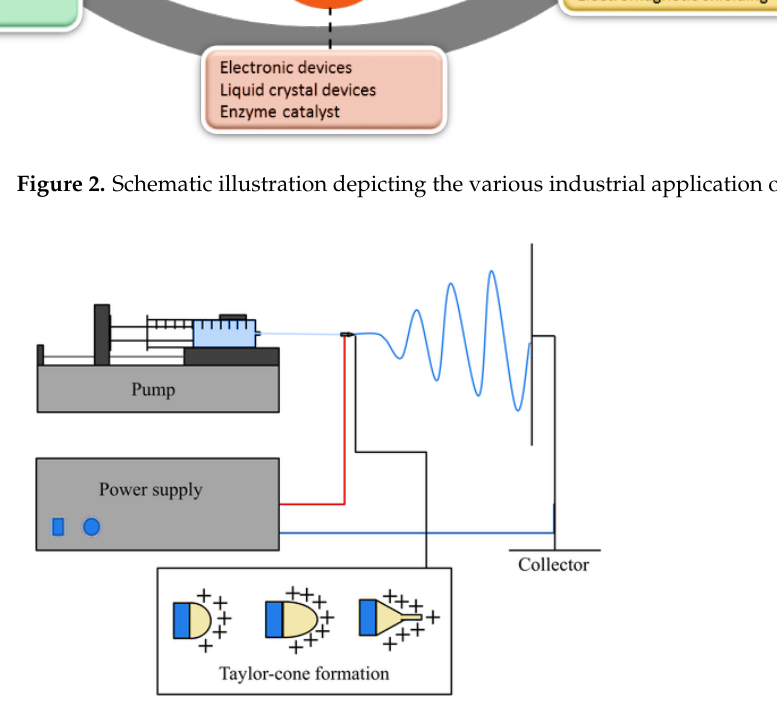
Figure 3. Schematic of a conventional electrospinning setup, reproduced with permission from